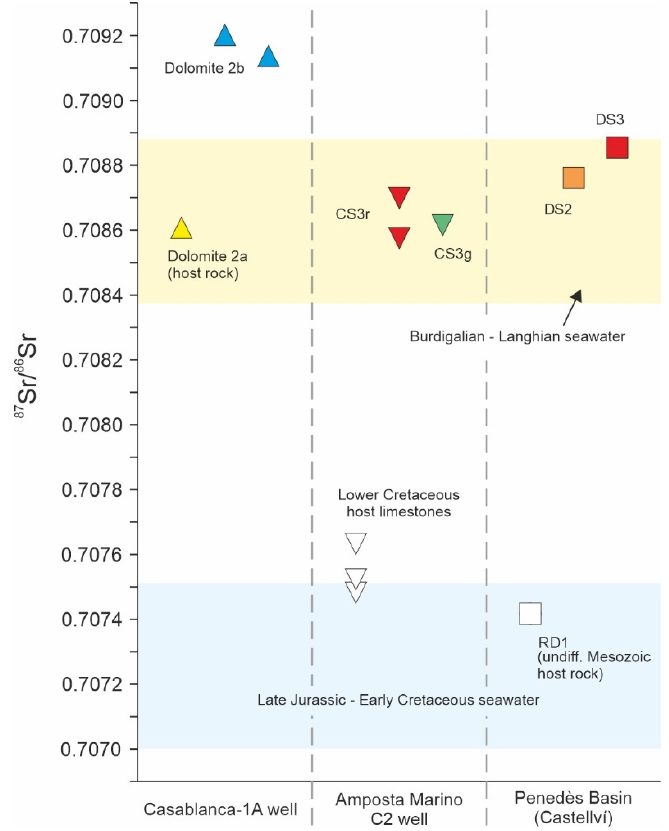
Figure 13. The 87 Sr/ 86 Sr ratios of the karst fills and host carbonates in the Casablanca and Amposta oil wells as well as in the Castellví outcrop in the Penedès Basin compared with values of Late Jurassic–Early Cretaceous and Burdigalian–Langhian seawater. Seawater ratios are from the LOWESS curve of [40] .